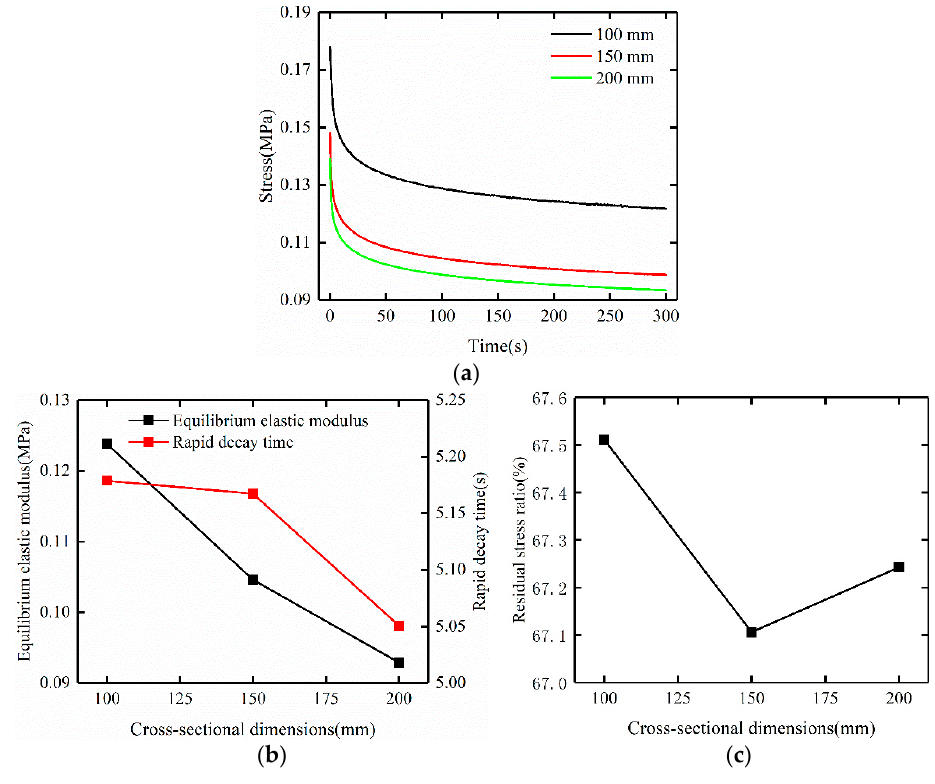
Figure 7. Stress relaxation characteristics at different cross-sectional dimensions: ( a ) Stress relaxation curve; ( b ) Equilibrium elastic modulus E e and rapid decay time T 1 ; ( c ) Residual stress ratio ε .